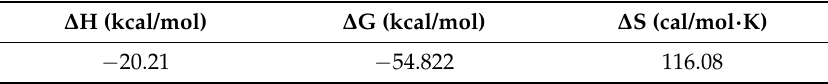
Table 6. The thermodynamic properties during preparing (C 2 H 5 ) 3 Al process. ∆ H